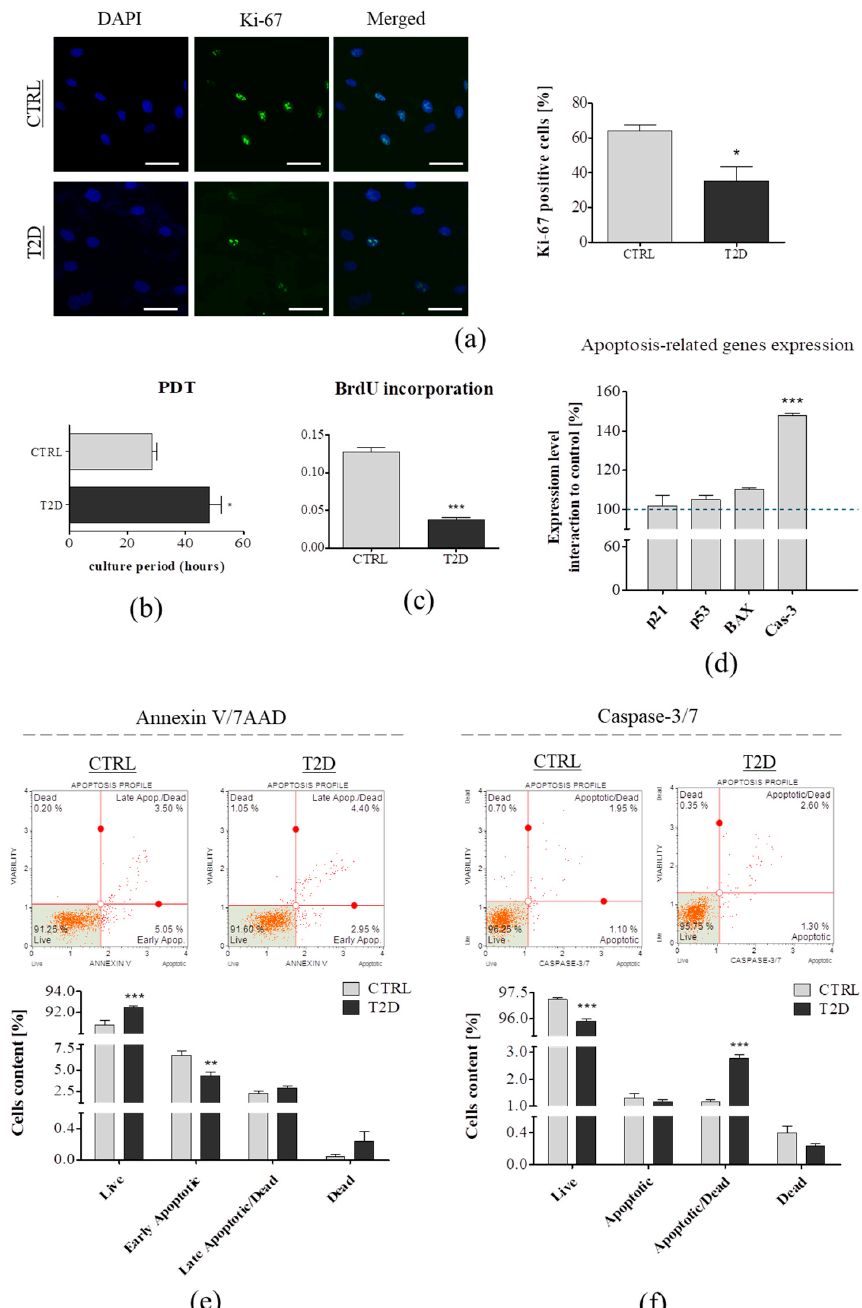
Figure 1. Comparison of proliferation and apoptosis in adipose-derived mesenchymal stem cells from non-diabetic donors (ASC CTRL ) ( n = 6) and patients with clinically confirmed type 2 diabetes (ASC T2D ) ( n = 6). ( a ) Representative images of immunofluorescence staining for Ki-67 (green). Nuclei were counterstained with 4 ′ ,6-diamidino-2-phenylindole (DAPI) (blue). Ki-67 expression in ASCs was showed as Ki-67 positive cells percentage. Scale bar: 50 µm. ( b ) population doubling-time (PDT) value was determined using TOX-8 Resazurin-based Assay. ( c ) BrdU incorporation assay. Cells were cultured with BrdU labeling medium for 18 h. ( d ) Transcript levels of the apoptosis-related genes was determined using the qRT-PCR method. The black dotted line indicated the transcript levels of genes in the ASC CTRL group. ( e , f ) Evaluation of apoptosis and cell death using the Muse Cell Analyzer. The percentage of live, apoptotic, apoptotic/dead, and dead cell was assessed using thee Annexin/7AAD and Caspase-3/7 tests. Results are expressed as mean ± SD. Statistical significance is indicated by asterisks (*); * p < 0.05, ** p < 0.01, *** p < 0.001, as examined by unpaired Student’s t -test.